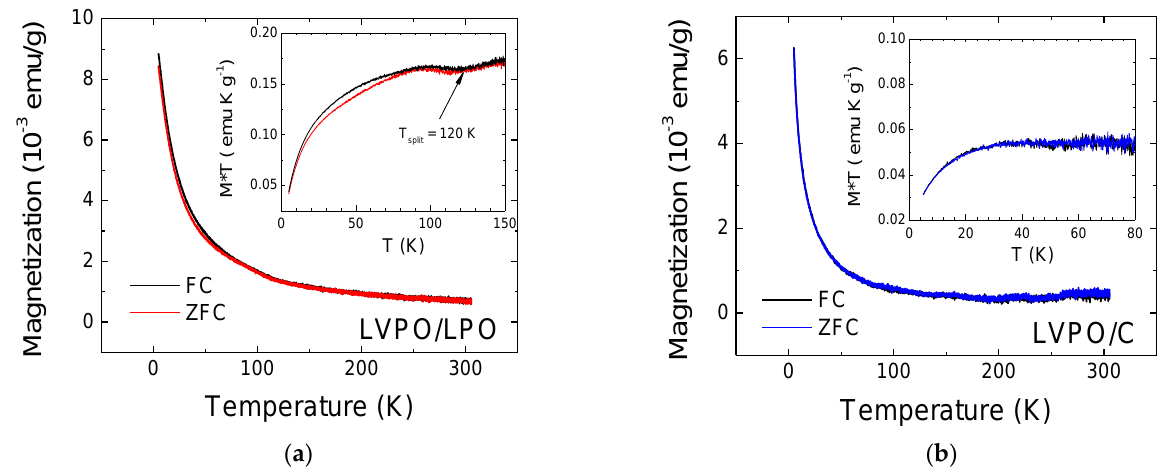
Figure 4. Temperature dependence of magnetization in ( a ) Li 3 V 2 (PO 4 ) 3 /Li 3 PO 4 and ( b ) Li 3 V 2 (PO 4 ) 3 /C measured in FC, ZFC regimes in the external magnetic field of H = 5 mT. Insets show the low temperature data in representation M∙T vs. T in more detail.